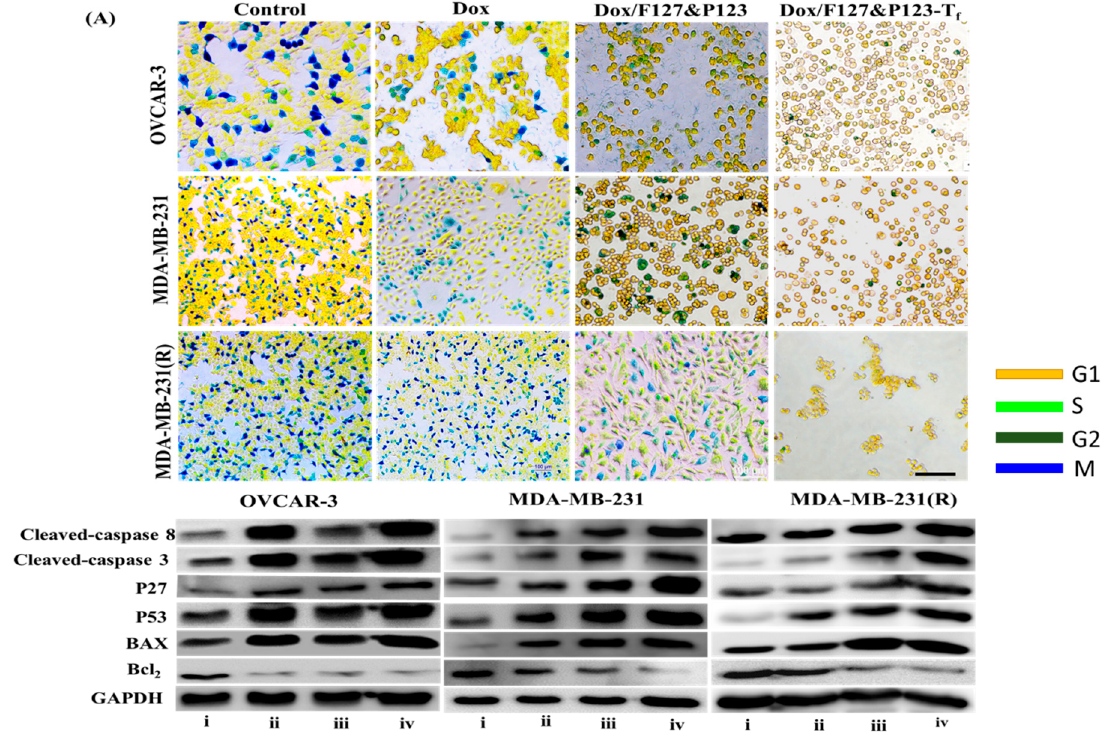
Figure 5. ( A ) Cell cycle analysis of OVCAR-3, MDA-MB-231, and MDA-MB-231(R) cells treated with Dox, Dox/F127&P123, and Dox/F127&P123-T f ; scale bars represent 100 µ m; ( B ) Western blot analysis of apoptotic and anti-apoptotic proteins induced in OVCAR-3, MDA-MB-231, and MDA-MB-231(R) cells treated with (ii) Dox, (iii) Dox/F127&P123 and (iv) Dox/F127&P123-T f for 24 h.